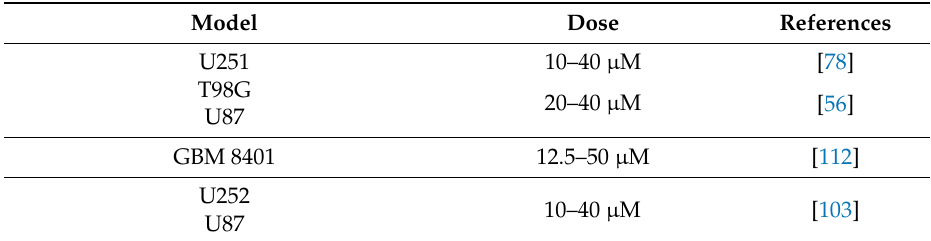
Table 1. Summary of studies focused on the anti-proliferative and pro-apoptotic properties of sulforaphane (SFN) in glioblastoma